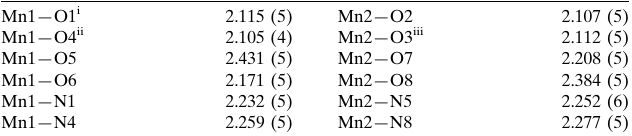
Selected bond lengths (A˚